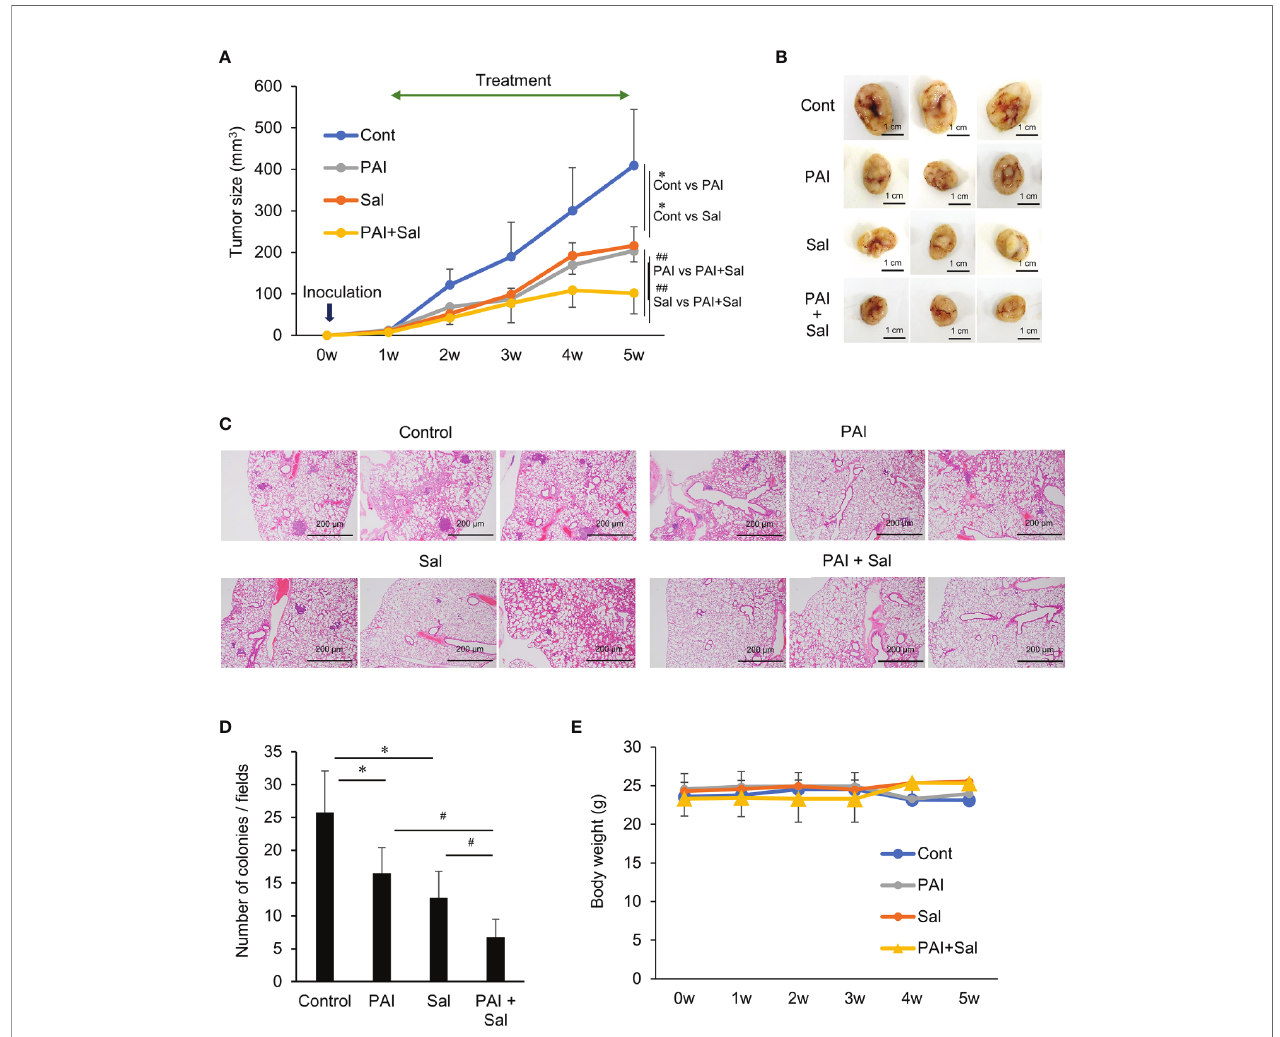
FIGURE 5 | Combined administration of PAI and Sal reduces the growth and metastasis of the murine OS Allograft model. (A) C3H mice were subcutaneously inoculated with LM8 cells (2 × 10 6 ) at day 0 and intravenously administered 200 m L of PAI (50%) and Sal (3 mg/Kg) alone or in combination 3 times per week for 4 weeks from day 7. The sizes of the tumors in the mice were measured every week. Values represent the mean ± SD (n = 6). * P < 0.05 compared with the corresponding control. ## P < 0.01 vs. PAI or Sal alone. (B) Representative photos of primary tumors at 5 weeks after inoculation of LM8 cells. Bar = 1 cm. Simultaneously, lungs were removed, and metastatic nodules on their surface were counted with a stereomicroscope. (C) Representative microscope image of lungs (hematoxylin-eosin staining). Bar = 200 m m. (D) Quantitative analysis of metastatic nodules in the lungs. Data were analyzed by one-way analysis of variance followed by Tukey ’ s post hoc test. Results are shown as mean ± SD. * P < 0.05 compared with the corresponding control. # P < 0.05 vs. PAI or Sal alone. (E) The weights of the mice were measured every week for 5 weeks. Data are the mean ± SD (n = 6). See Supplementary Figure 7 schematic fl owchart and photos of the tumor-bearing